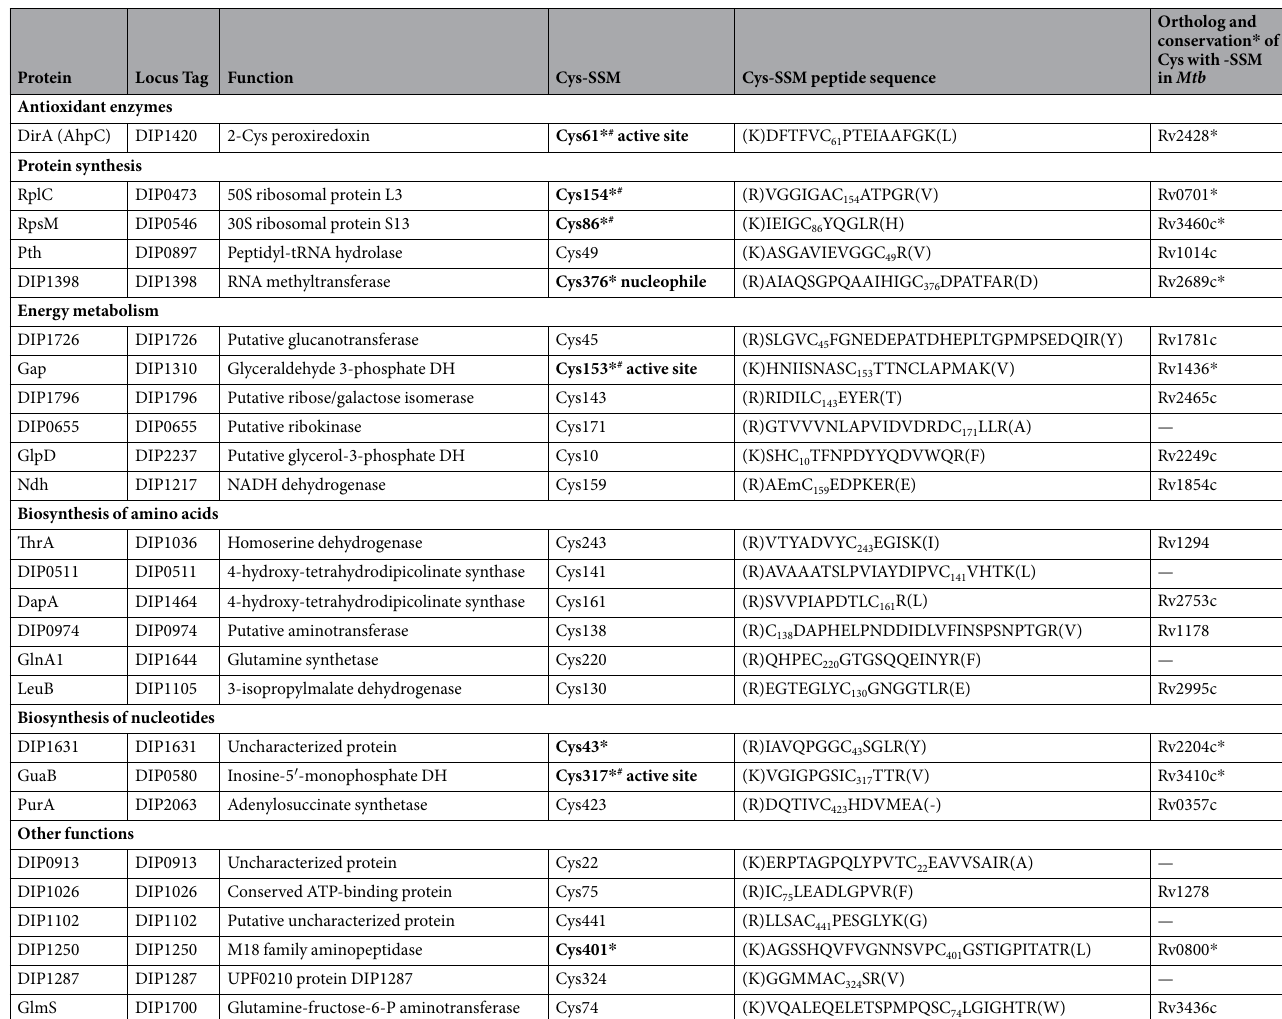
Table 1. Identification of 26 S -mycothiolated proteins in C. diptheriae DSM43989 using shotgun LC-MS/